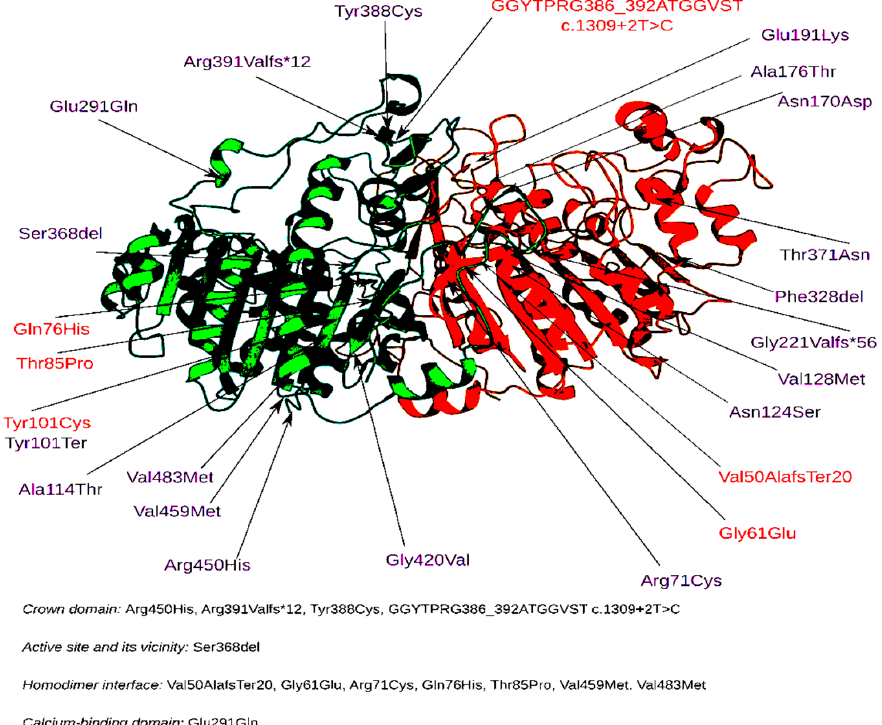
Figure 7. Localization of amino acids in TNSALP protein domains in Russian patients (compound heterozygotes only). The altered amino acids identified in the Russian population are highlighted in red.